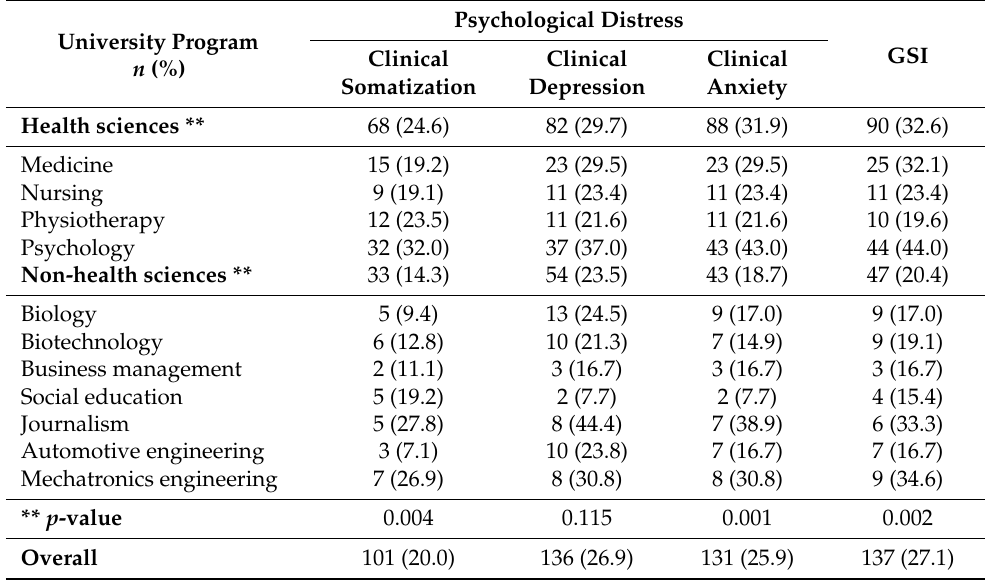
Table 2. Prevalence of psychological distress ( n = 506). Values are expressed as number of students, and percentages are in